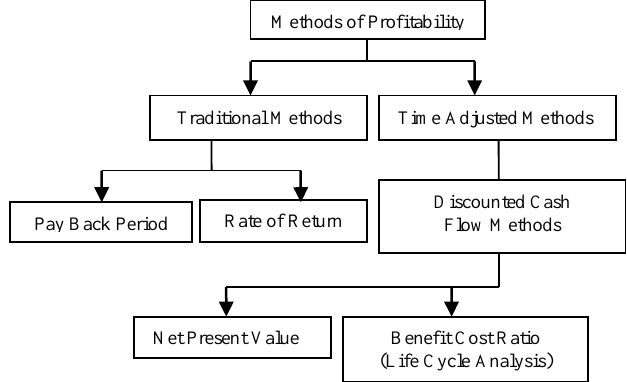
Fig. 1. Classification of profitability